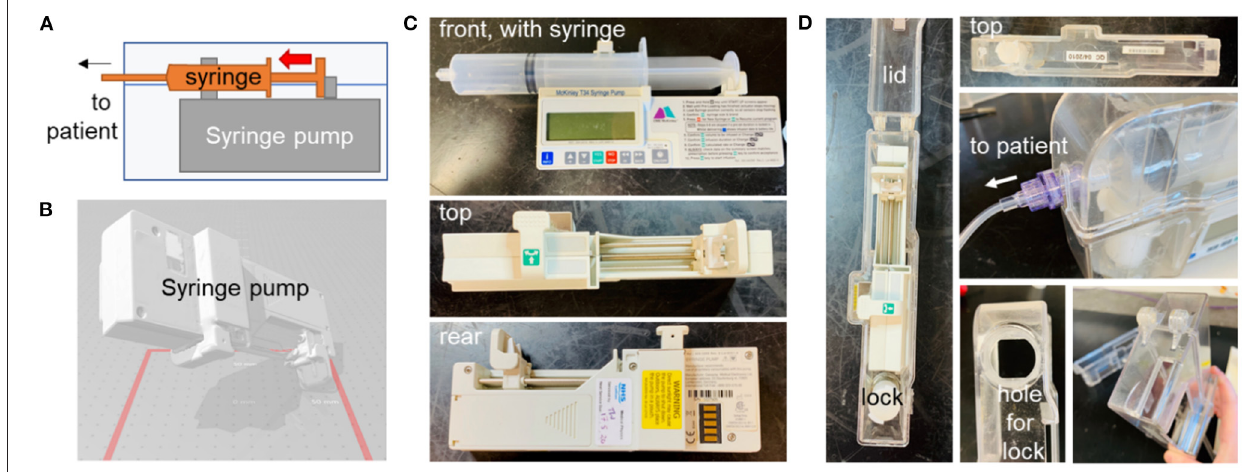
FIGURE 10 | Syringe pump and original lockbox. (A) Schematic diagram showing syringe pump with syringe, enclosed in lock-box. (B) Optical scan of pump, to assist with dimensioning of new box. Photographs of syringe pump (C) and existing lock-box (D) , various